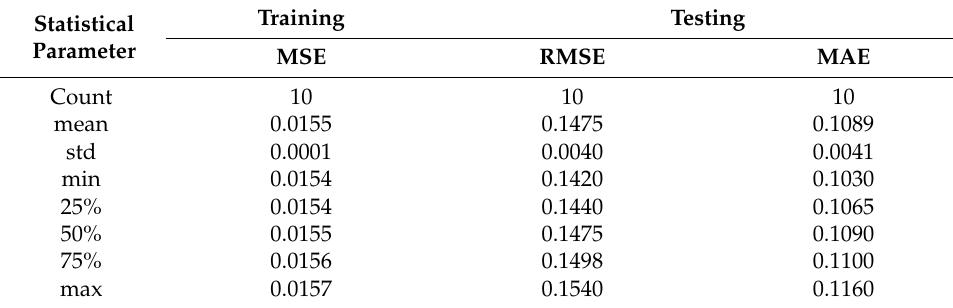
Table 14. Statistical training performance of model RDM-1.